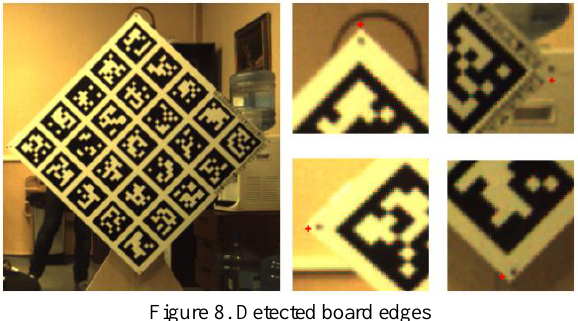
Figure 8. Detected board edges Detection of the board edges in the LiDAR point cloud is shown in Figure